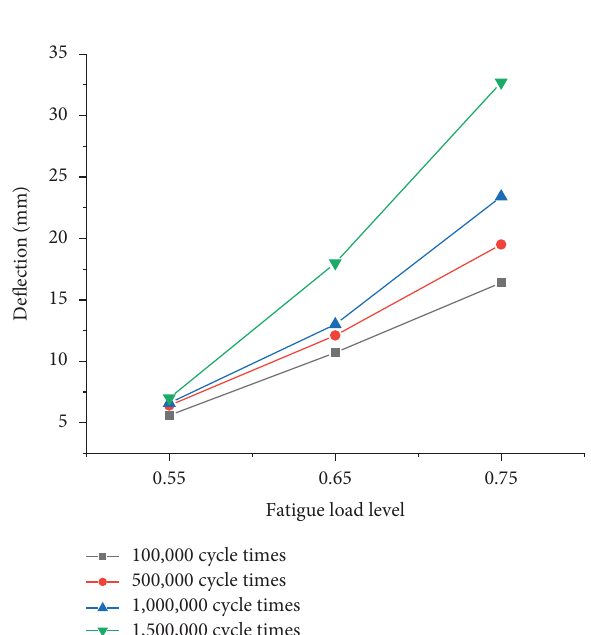
Figure 15: Horizontal relation curve between defection and the fatigue load